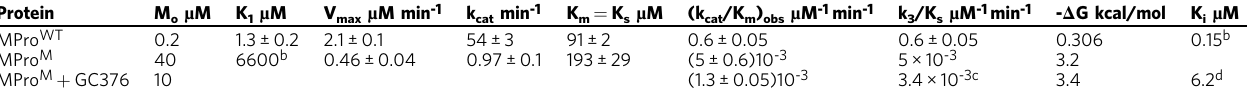
Table 1 Kinetic, thermodynamic and inhibition parameters of MPro WT and MPro M -catalyzed hydrolysis of peptide substrate a . Protein